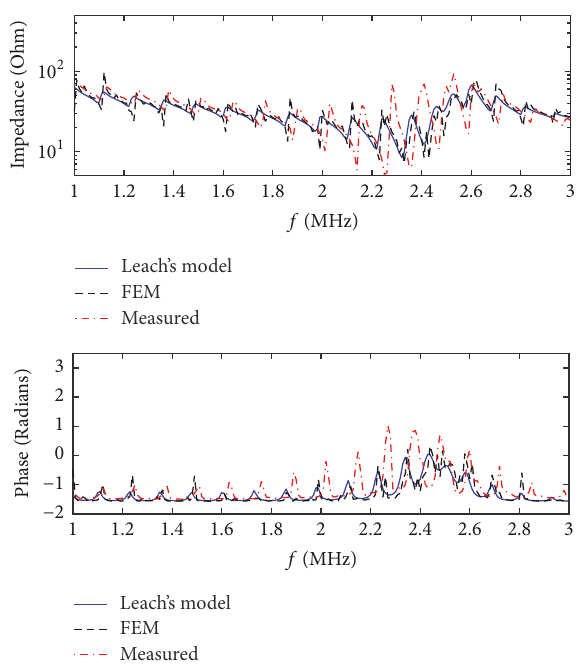
Figure 12: Equivalent input impedance of the channel through a planar metal